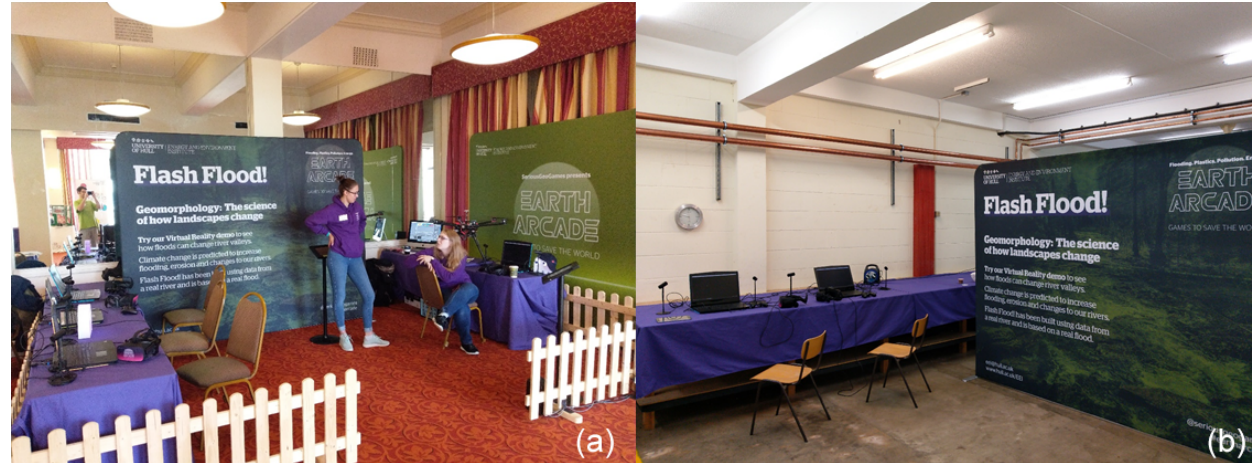
Figure 6. Exhibit set-up for the Scarborough Science and Engineering Week (a) and the British Geological Survey Open Day (b) . The iPad and stand for the evaluation station at the British Geological Survey Open Day is just off shot to the right of the